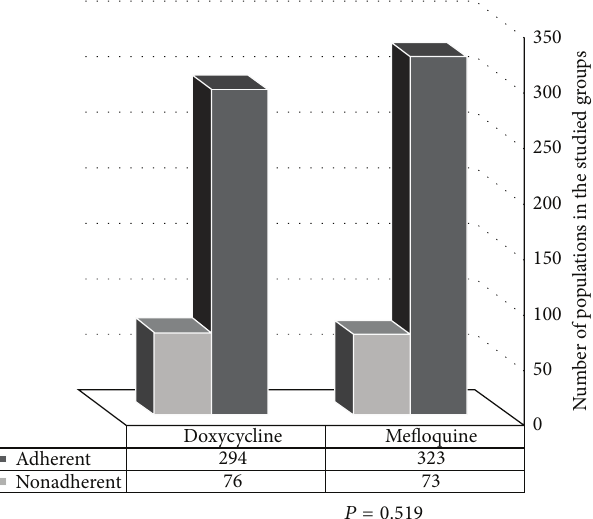
Figure 1: Comparison between the mefloquine and doxycycline groups according to